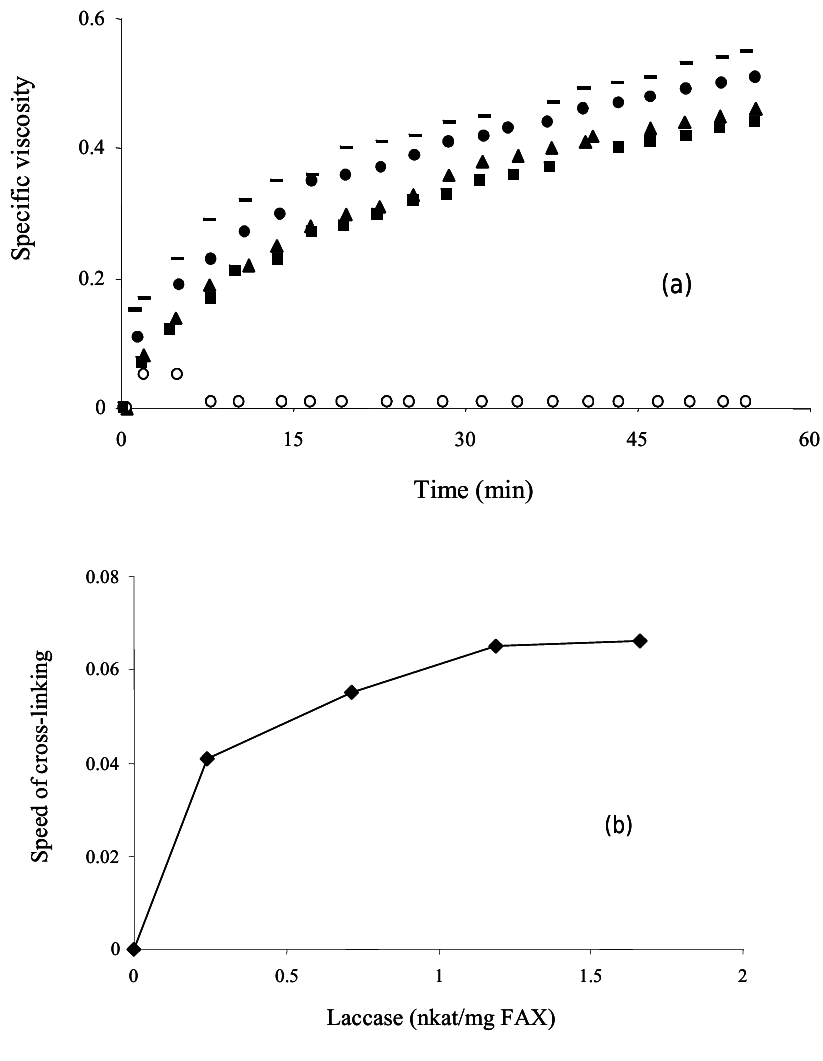
Figure 2. (a) Capillary viscosimetry profiles of ferulated arabinoxylans solutions at 0.5% (w/v) treated with different amounts of laccase 0 ( ○ ), 0.2 ( ■ ), 0.7 ( ▲ ), 1.2 ( ♦ ) and 1.7 (–) nkat/mg ferulated arabinoxylans. (b). Rate of cross-linking of ferulated arabinoxylans as a function of laccase content. Measurements at 25 °C in 0.05 M citrate-phosphate buffer pH 5.